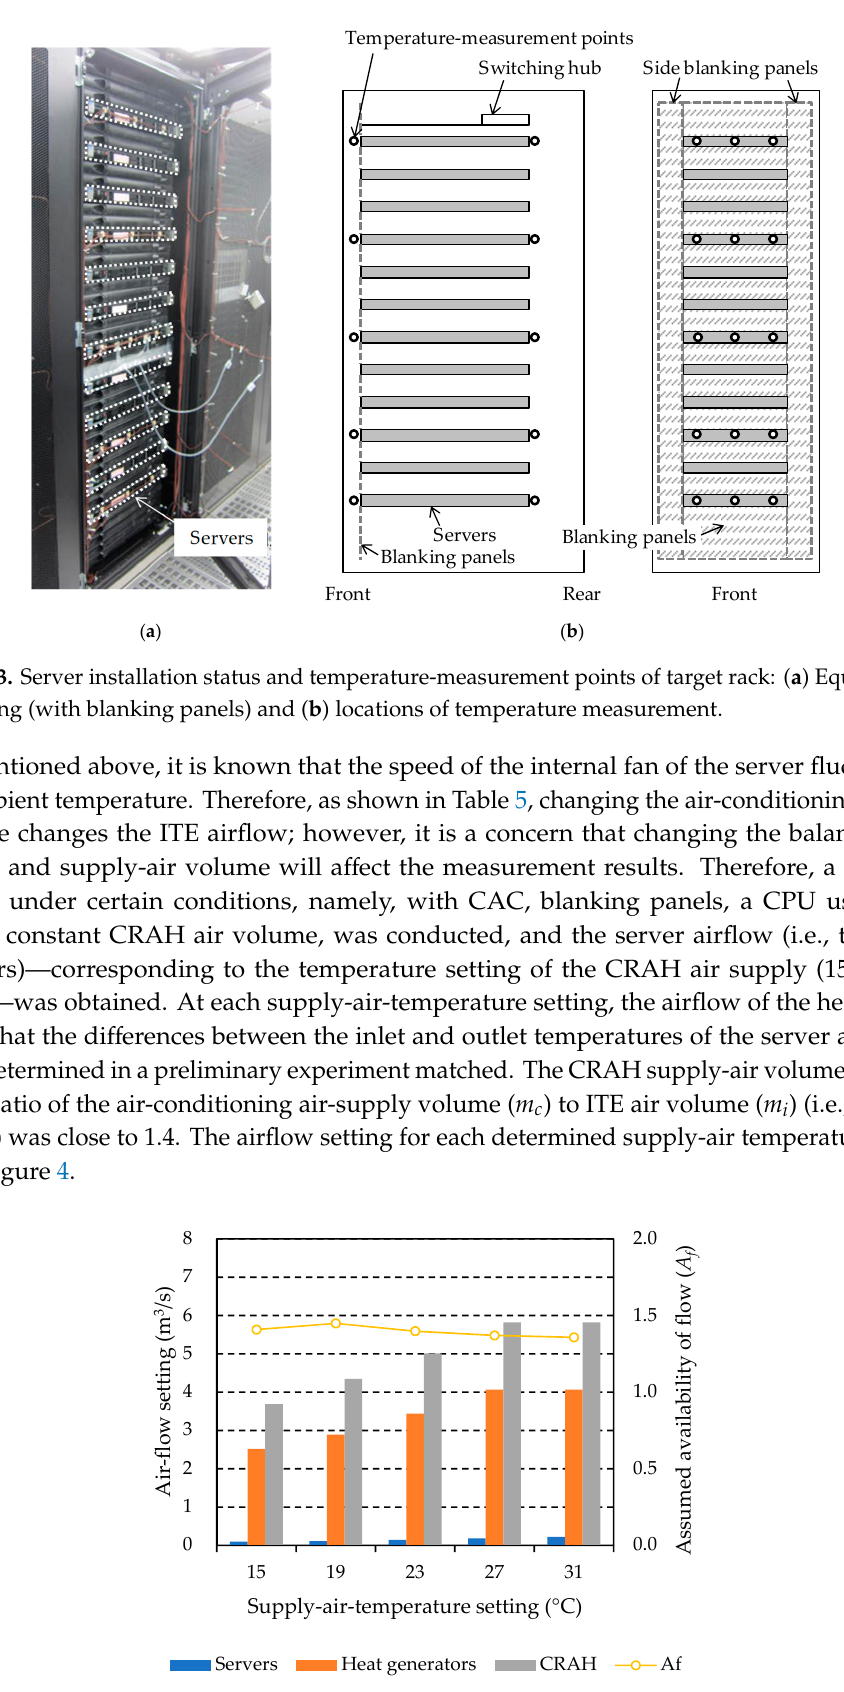
Figure 4. Airflow-rate setting and assumed availability of flow ( A f ) for each supply-air-temperature setting.